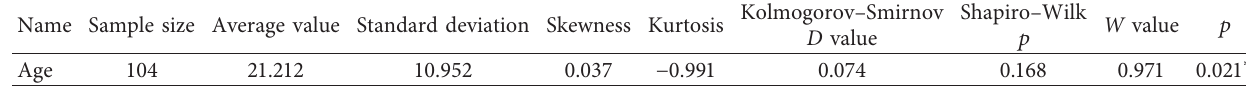
Table 4: Normality test